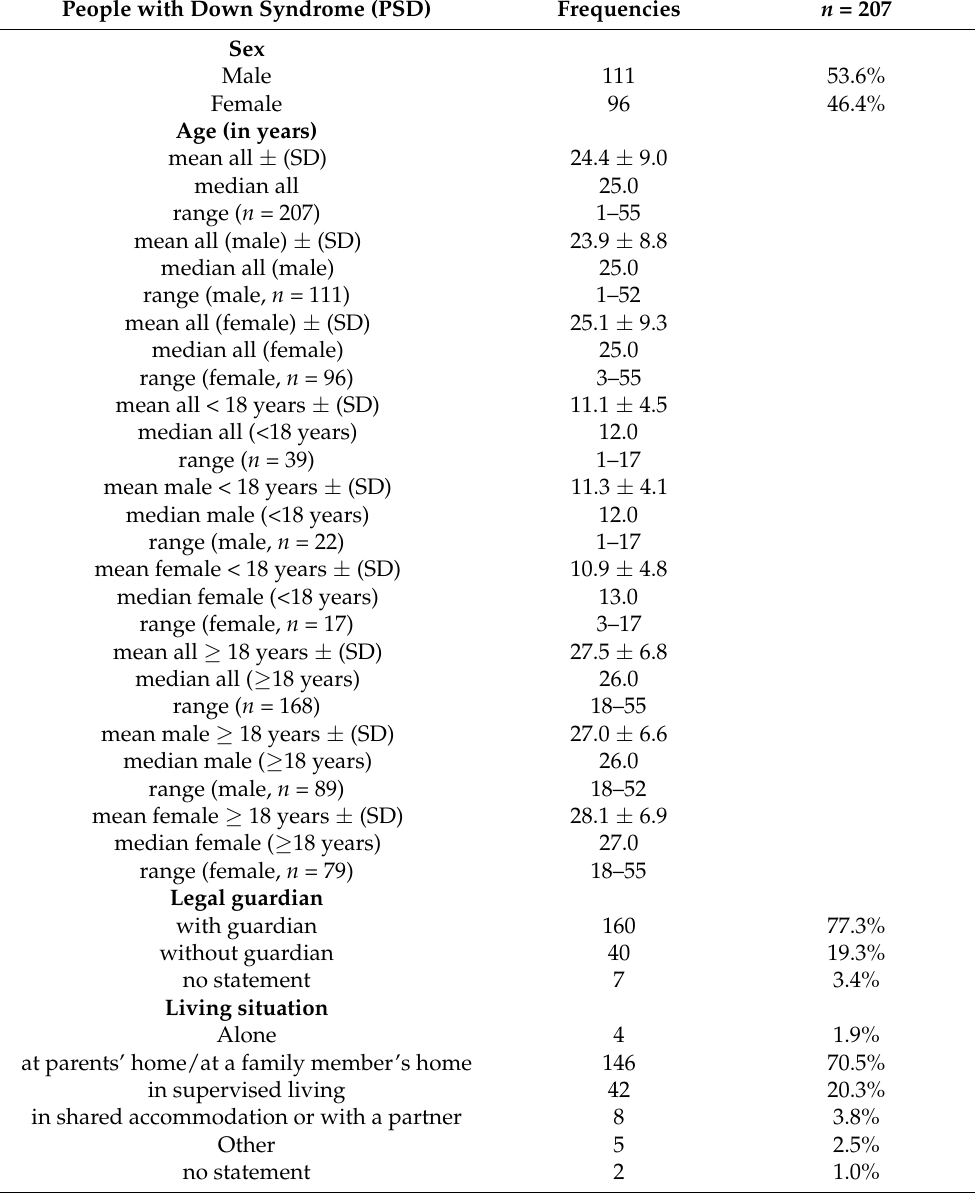
Table 2. Characteristics of the People with Down Syndrome (PDS) as the study population. People with Down Syndrome (PSD)